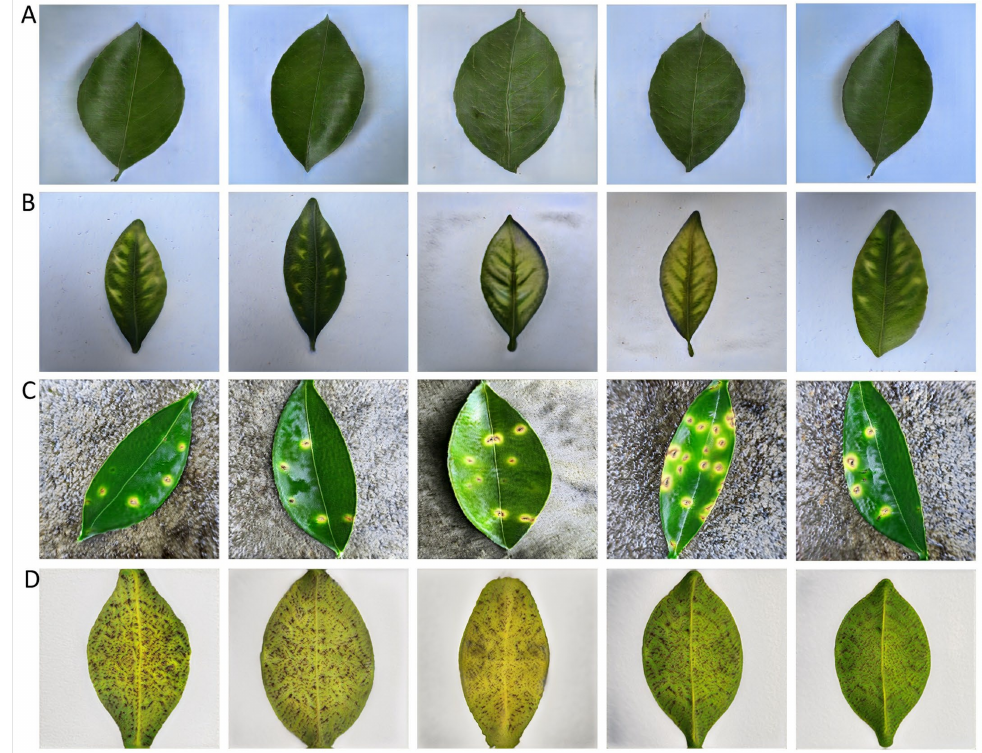
Figure 10. A portion of the dataset generated by FastGAN2: ( A ) healthy; ( B ) nutritional deficiency; ( C ) canker; ( D )